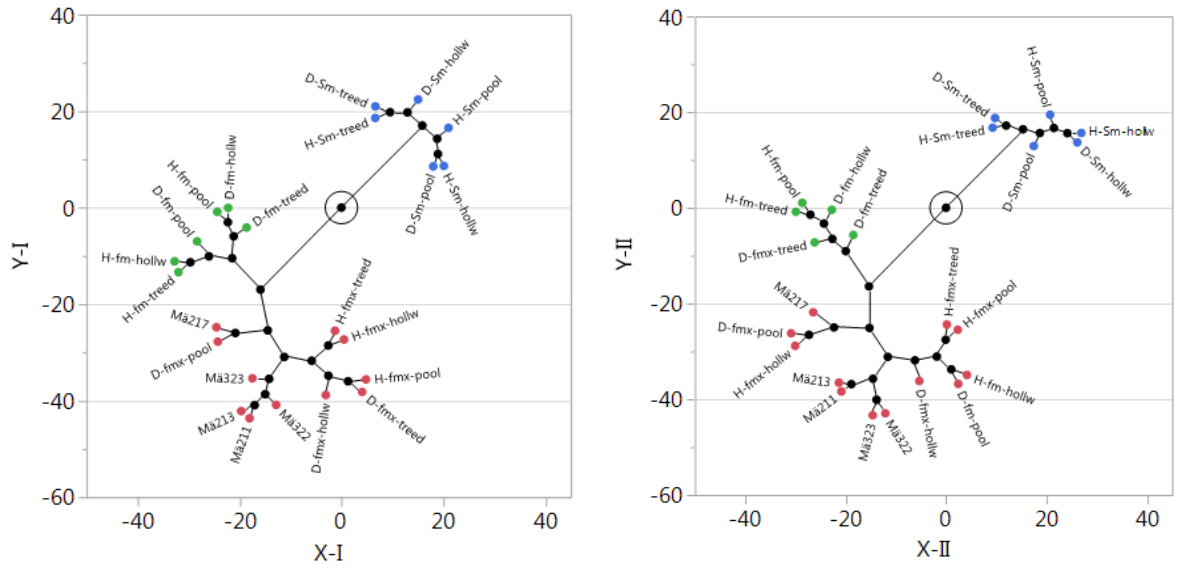
Figure 11. Constellation plots of distance-scaled dendrograms of Männikjärve Bog (Mä) ground-level variables for average winter seasons (Periods I and II). The variables used are: mean (fm) and maximum (fmx) soil frost depths; and mean snow depths (Sm) in depressions (D) and hummocks (H) of treed, ridge- hollow and ridge-pool ecotopes. Abbreviations for the ecotope groundwater levels are: Mä217 = treed;